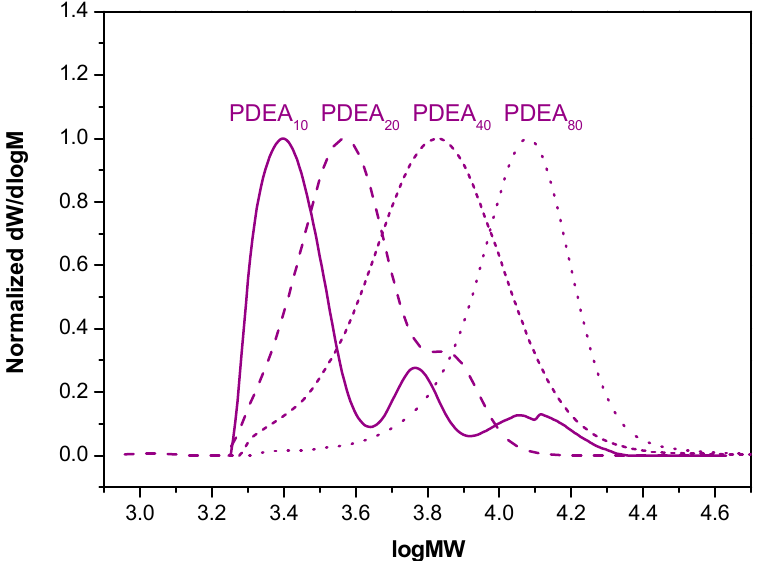
Figure 3. The evolution of molecular weights of PDEA (DP = 10–80) catalyzed by the generated Cu(0) particles/CuBr 2 /Me 6 TREN complex in water determined by GPC using DMF as the mobile phase.